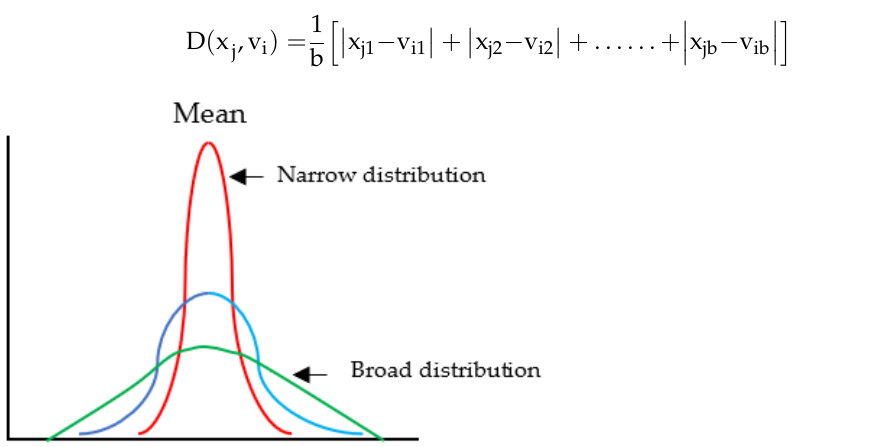
Figure 6. Schematic Diagram of Mean Absolute Difference Distance Measures.